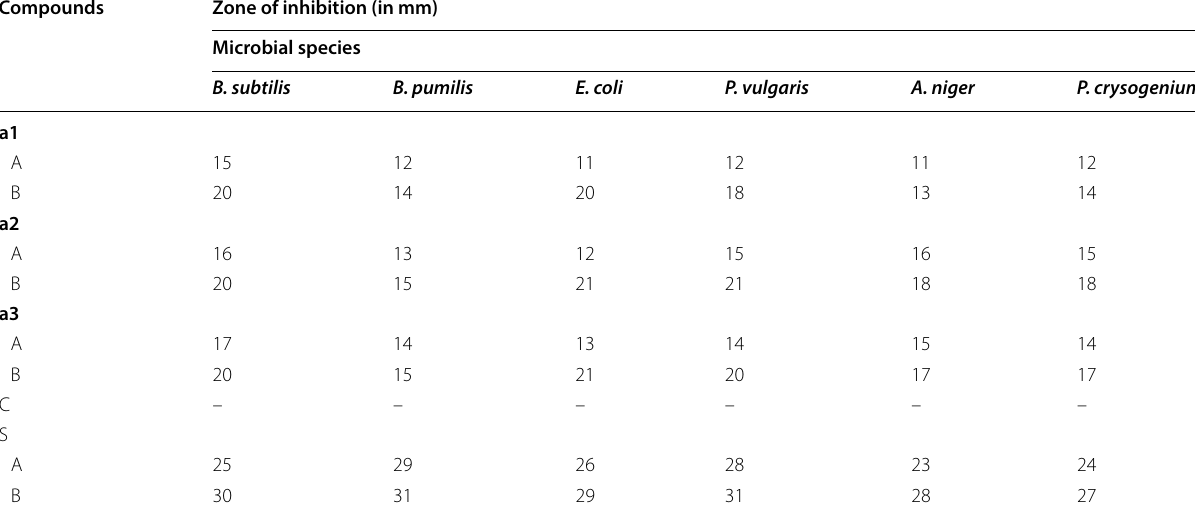
Table 1 Antimicrobial activity of compounds